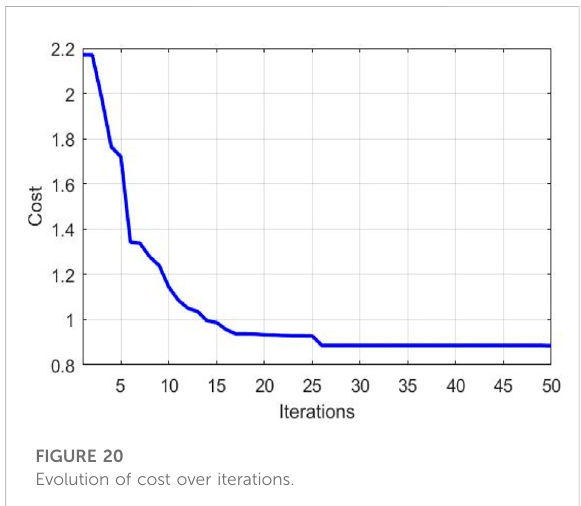
Evolution of cost over